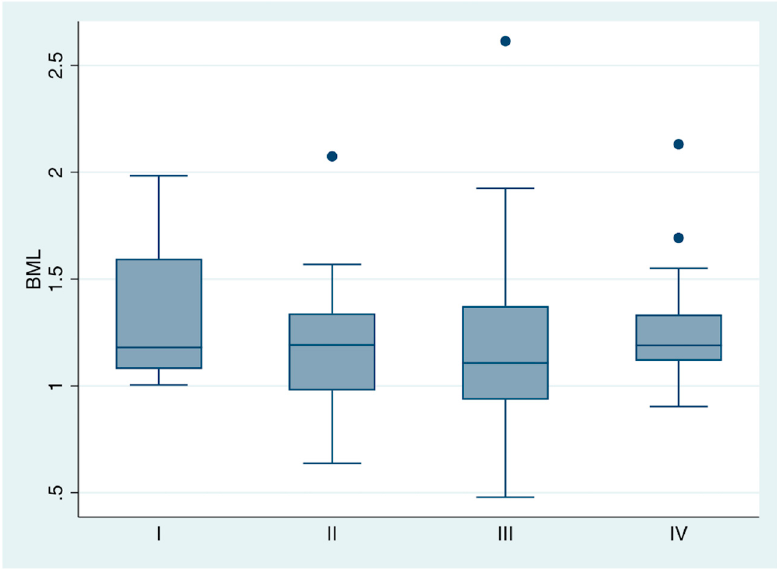
Figure 2. Box plot for esophageal cancer. Bone marrow-to-liver SUV (BML) vs. pretreatment clinical stage.